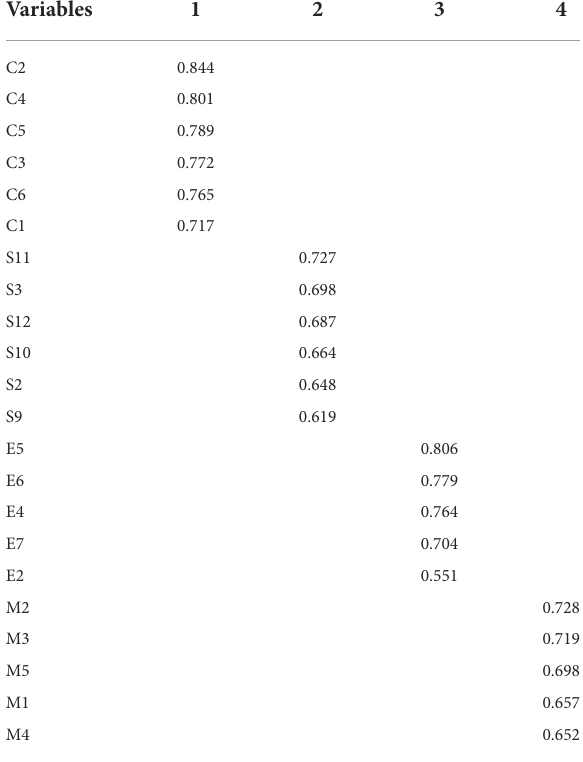
TABLE 3 Rotated component matrix a .